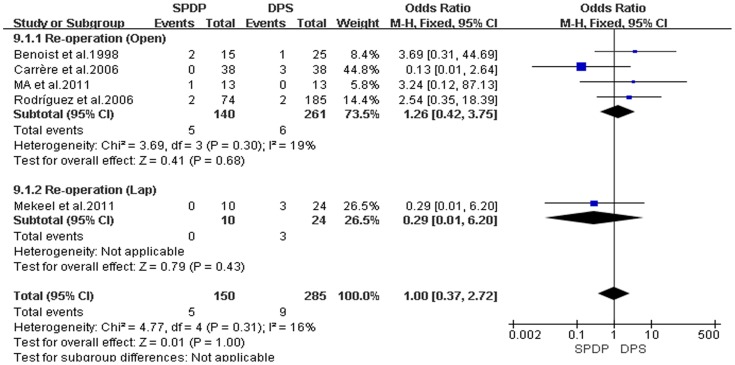
Re-operation (IV, Inverse variance; M-H, Mantel-Haenszel; CI, Confidence Interval; SD, standard deviation).